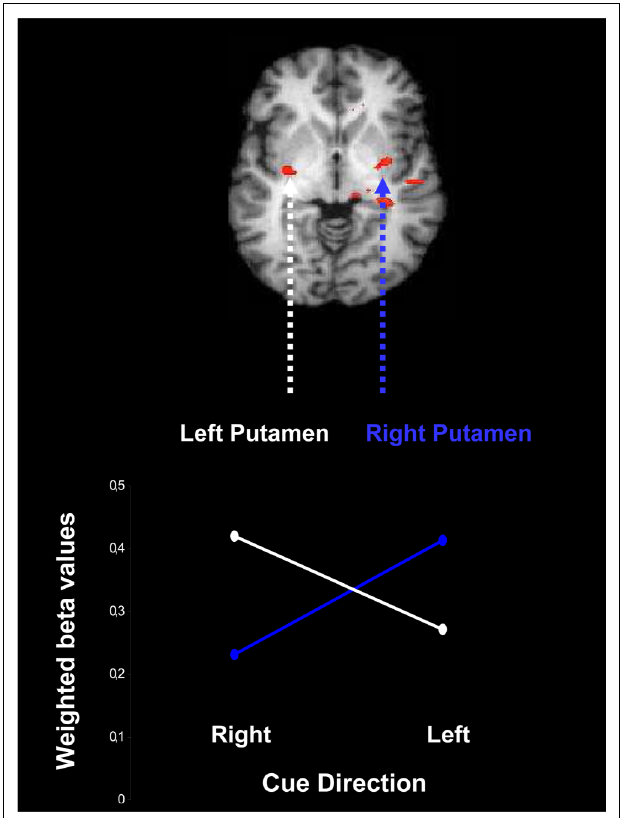
FIGURE 6 | Contralateral activation of the putamen due to presentation of a probabilistic cue for rightward and leftward movement of an upcoming stimulus. Weighted beta values are based on the conjunction of areas active both in the contrast for reliable vs. neutral cues and in the contrast for moderate vs. neutral cues, separately for leftward cues and rightward cues. The beta values are weighted by the change in cue-induced individual bias parameters estimated from the LBA